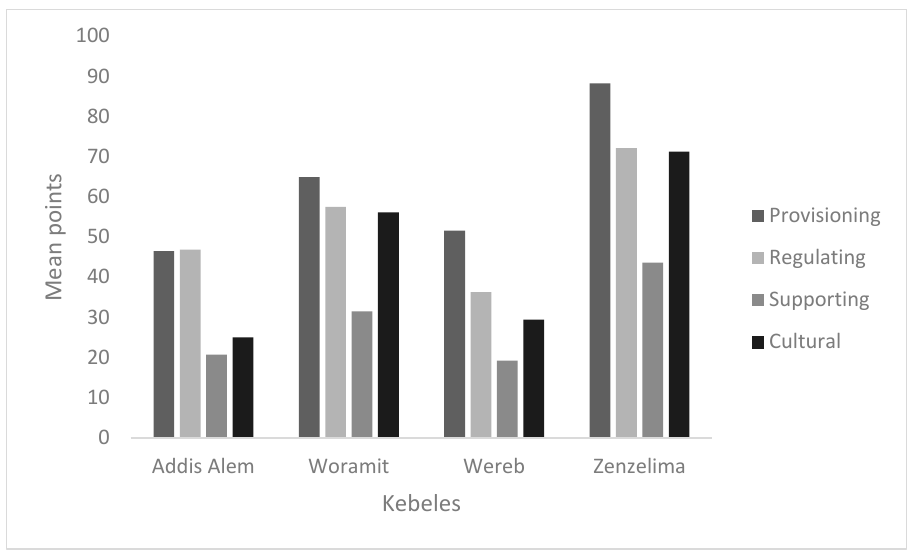
Figure 2. Comparisons of relative use (using aggregate mean points) of ES by kebeles .